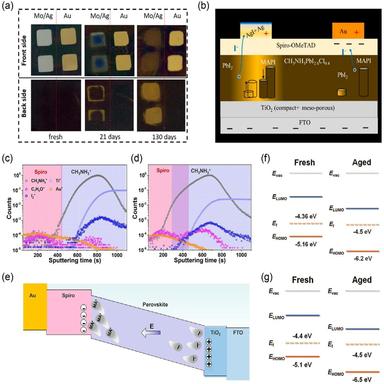
(a) Photographs of the front and backside of a PSC sample with both type of electrodes at different aging times at 24 C, in N2 atmosphere, dark, humidity below 10%. (b) Schematic of I migration in PSCs . Copyright 2016, American Chemical Society. Time-of-flight secondary ion mass spectroscopy (ToF-SIMS) of fresh devices (c) and degraded devices (d). (e) Schematic of ion migration under electric field in PSCs. Copyright 2017, American Chemical Society. Changes in energy levels of PTAA (f) and S